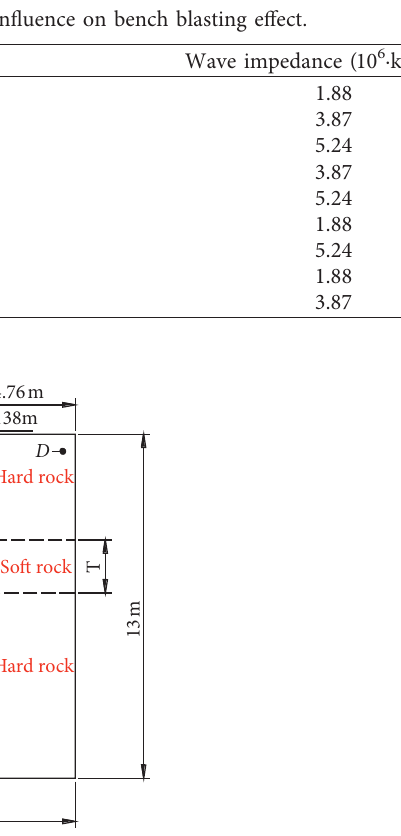
Figure 1: Schematic diagram of the geometry of the numerical model. Table 2: Design parameters of the numerical blasting